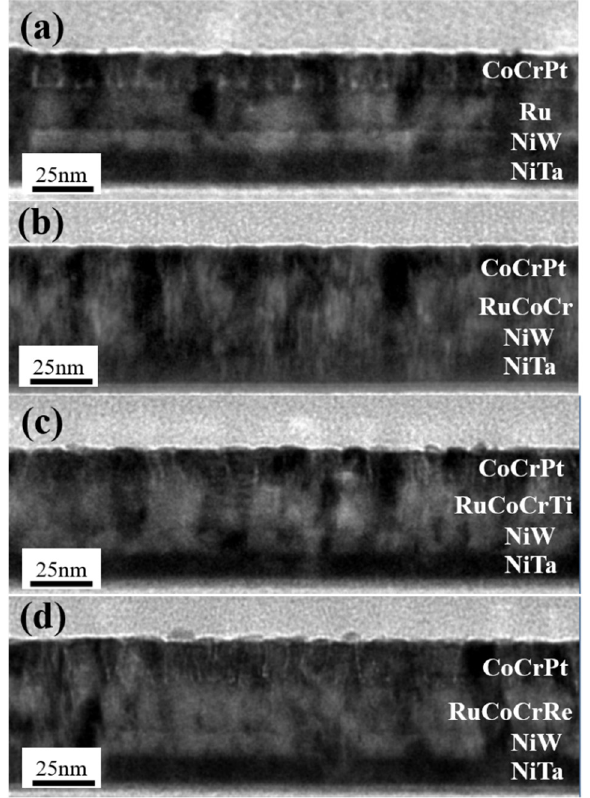
Figure 4. Cross-section TEM images of CoCrPt / y / NiW / NiTa, here y is ( a ) Ru, ( b ) RuCoCr, ( c ) RuCoCrTi, and ( d ) RuCoCrRe intermediate layer.